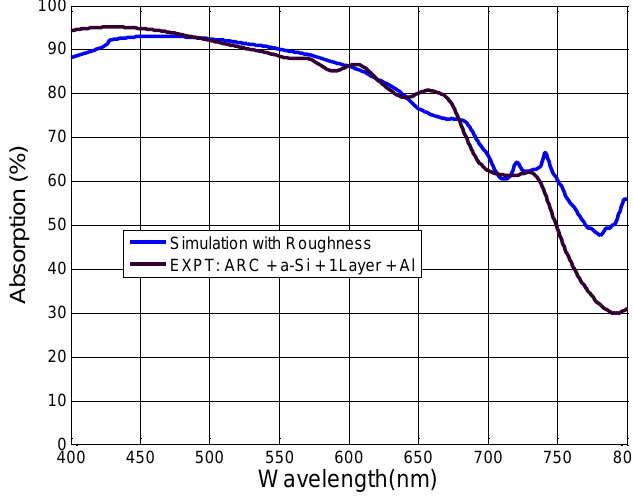
Figure 15. Absorption characteristics for the structure with an AR coating, 1 Layer DBR and aluminum layer. The graph compares the experimental results (purple plot), with the simulation results that incorporate roughness (blue plot).